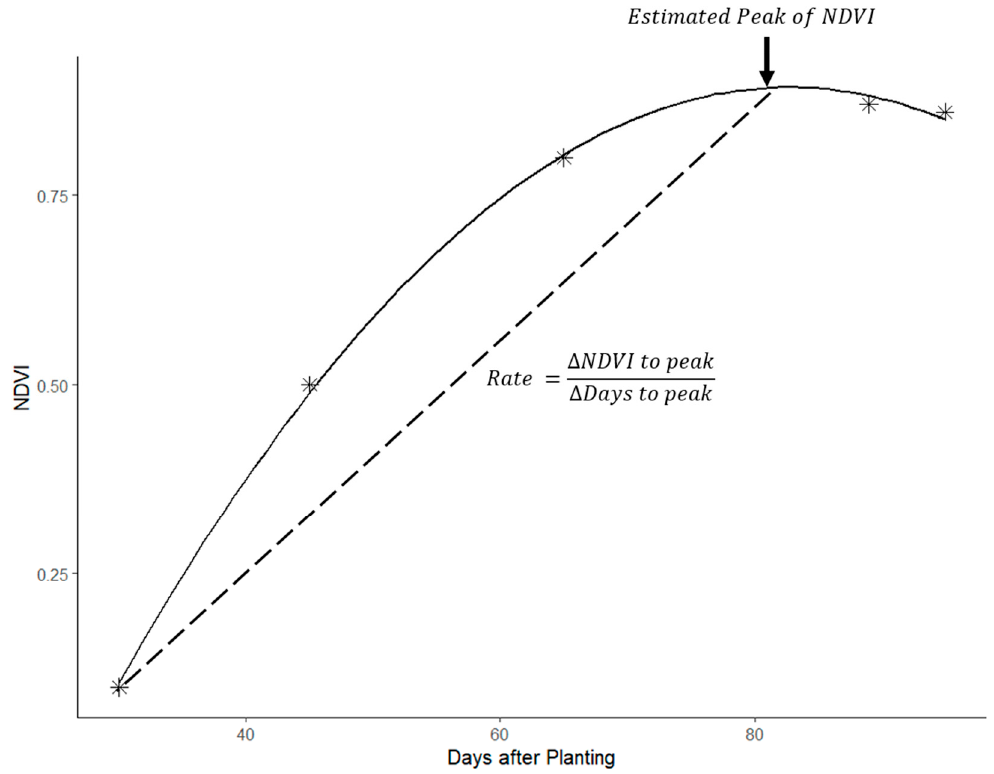
Figure 2. An illustrative graph showing how spectral index values like the Normalized Difference Vegetation Index (NDVI) were plotted in time and their peak and rate parameters derived.